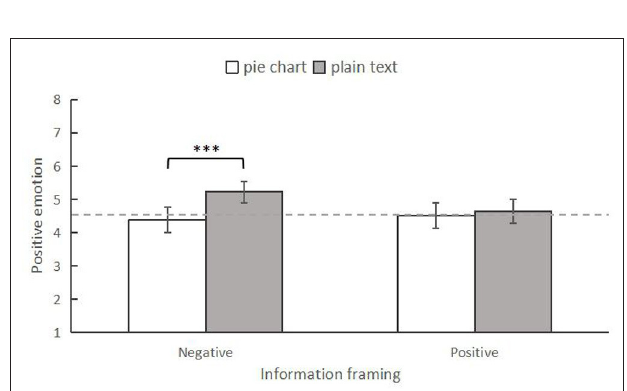
FIGURE 4 | The interaction between information frame and information form on positive emotion in Experiment 1. *** p < 0.001. The error bars indicated 95% CI.